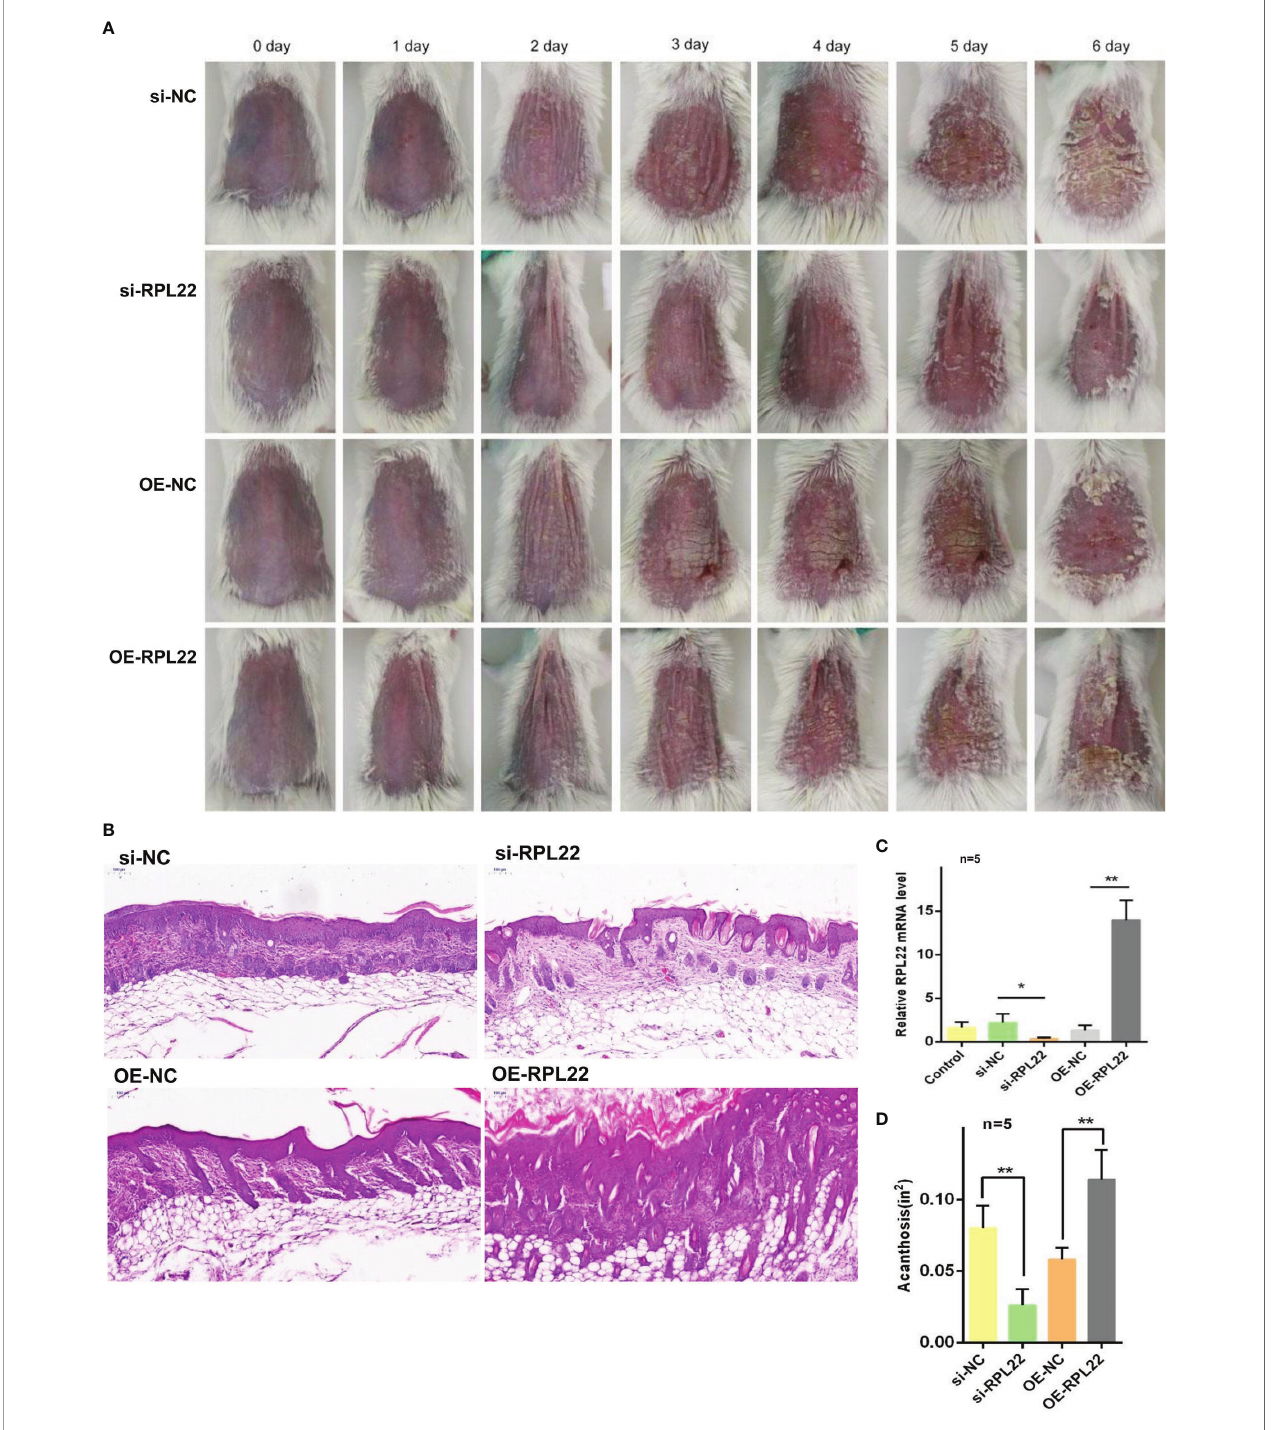
FIGURE 7 | RPL22 overexpression accelerates the development of psoriatic lesions (A) Clinical ef fi cacies on skin lesions in IMQ mice models after RPL22 intervention in four groups of si-RPL22, si-NC, OE-RPL22 and OE-NC. (B) H&E staining of lesional skin from mice in the above four groups to show pathological manifestation including acanthosis and dermal in fl ammatory cells in fi ltration. (C) RT-qPCR to detect the RPL22 mRNA expression level in lesional skin from IMQ- induced psoriasis-like mouse model intradermally injected with si-RPL22 or si-NC or OE-RPL22 or OE-NC (n = 5). (D) Acanthosis was quanti fi ed for IMQ-induced mice treated with si-RPL22 or si-NC or OE-RPL22 or OE-NC (n = 5). Data represent the mean ± SEM. *P < 0.05, **P < 0.01. Two-tailed unpaired Student ’ s t test was